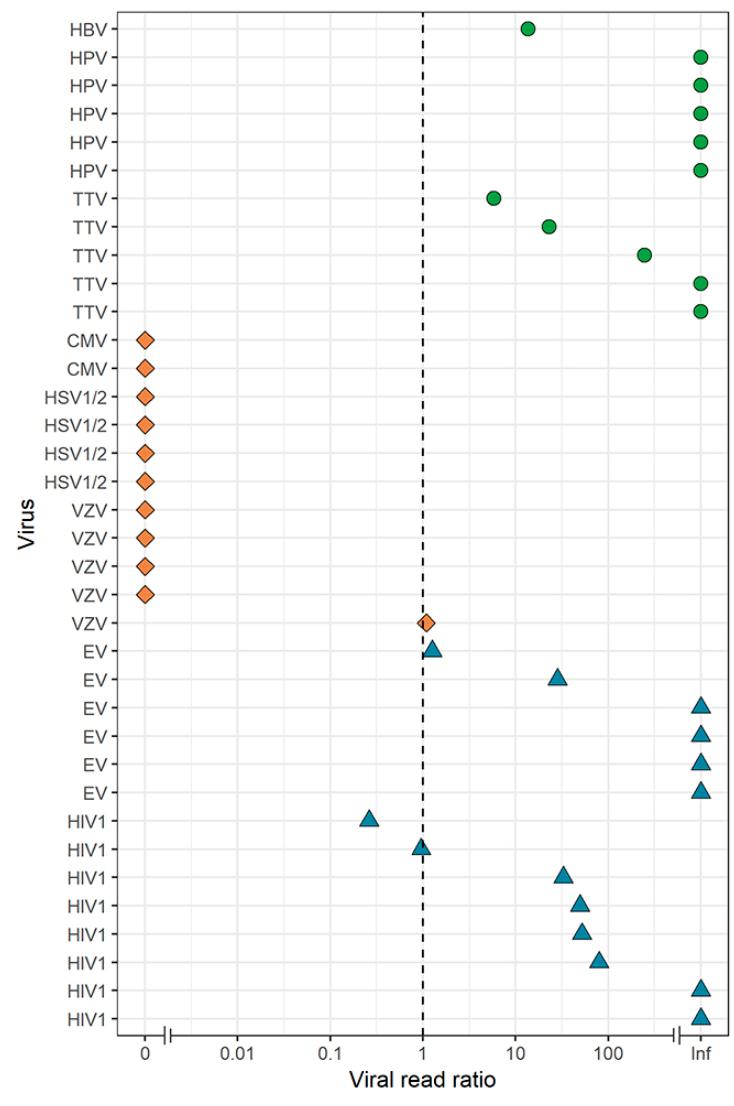
Figure 5. E ff ect of DNase on the detection of RNA and DNA viruses by VIDISCA-NGS in CSF. Viral read ratio (x-axis) is calculated as the ratio between the number of viral reads for samples with and without a DNase treatment, adjusted for the sequencing depth. Samples with a ratio > 1 favor regular library preparation whereas samples with a ratio < 1 favor a DNase-free treatment. Green dots: non-herpes DNA viruses, orange diamonds: herpesviruses, blue triangles: RNA viruses. On the y-axis, the viral species are displayed.